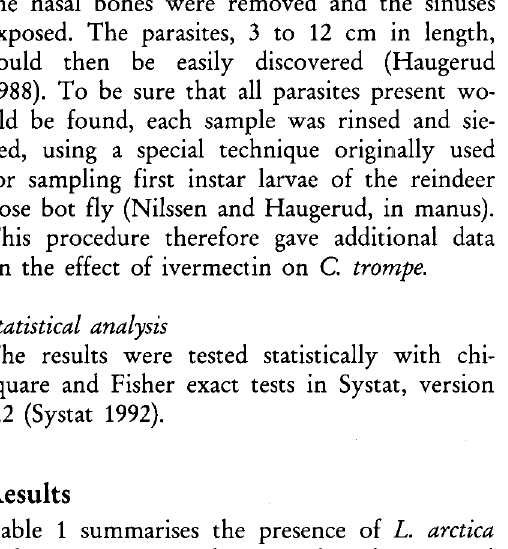
Table 1. Effect of ivermectin treatment on the prevalence of L. arctica and C. trompe in reindeer. The number of reindeer calves with and without the reindeer sinus worm and the reindeer nose bot fly in the treated and untreated (control) group three months after treatment.